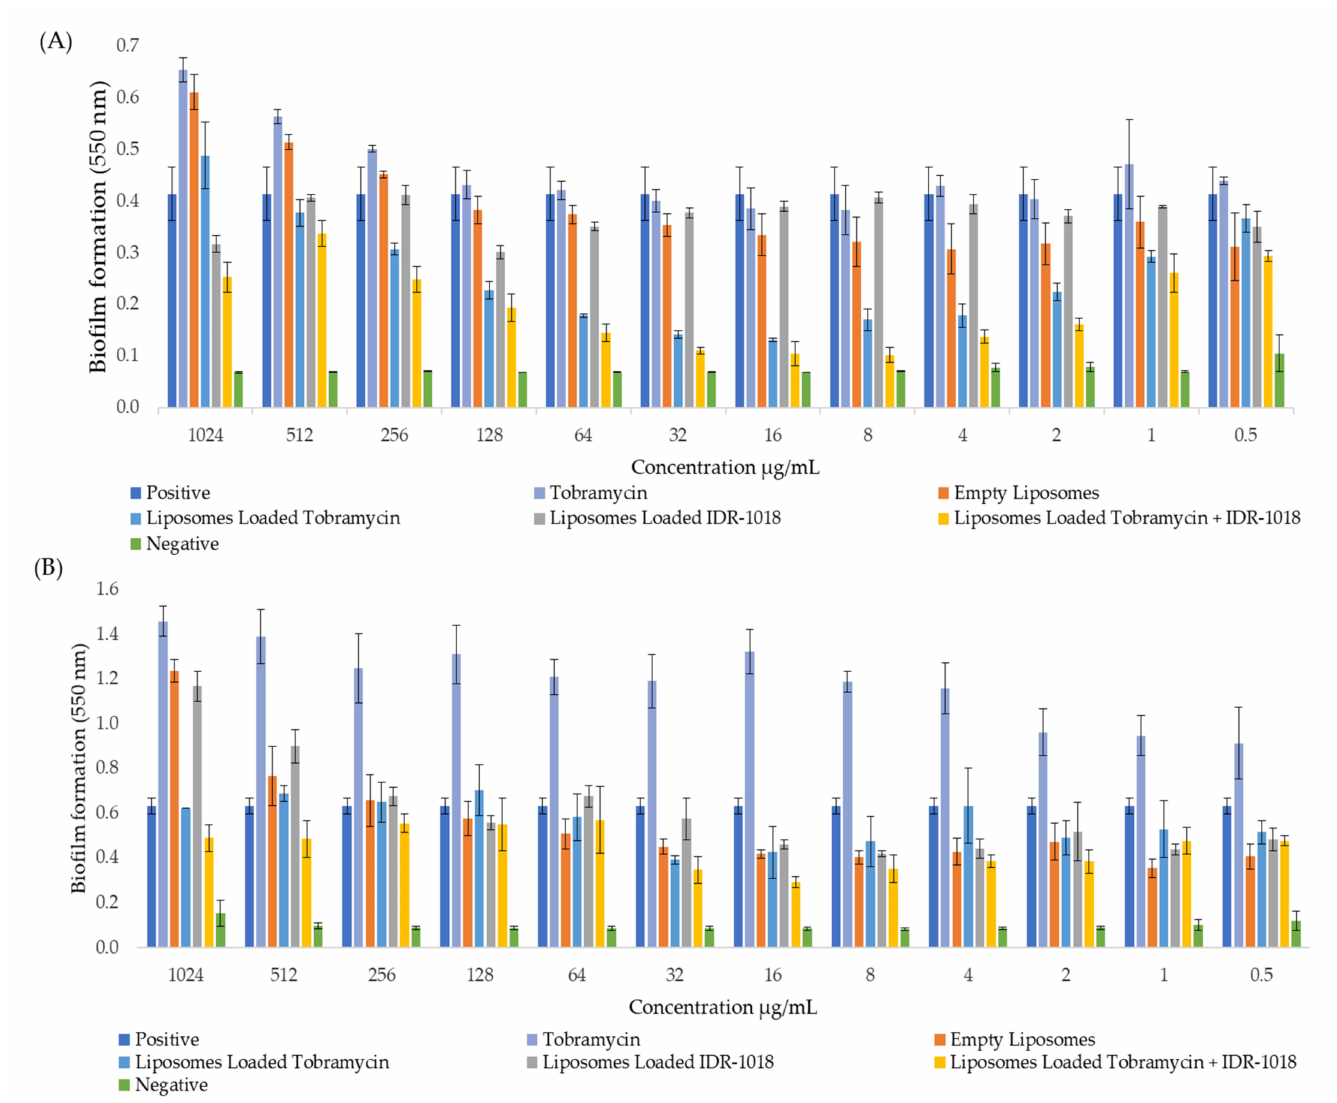
Figure 3. Biofilm formation of P. aeruginosa strains, showing biomass measurements, based on OD at 550 nm after 48 h exposure and the application of free tobramycin and different liposomal formulations. ( A ) PA01 as the control strain; and ( B ) MDR 7067 as the resistant strain. PA01 biofilm formation was reduced considerably with tobramycin-loaded liposomes and tobramycin and IDR-1018 peptide-loaded liposomes, with the activity being more significant ( p < 0.05) than the free tobramycin. The increase in biofilm formation was observed gradually with the increasing tobramycin concentration. Results are represented as mean ± SD (n = 3). OD: optical density. Positive and negative controls are wells containing only bacterium and culture medium, respectively, without adding any